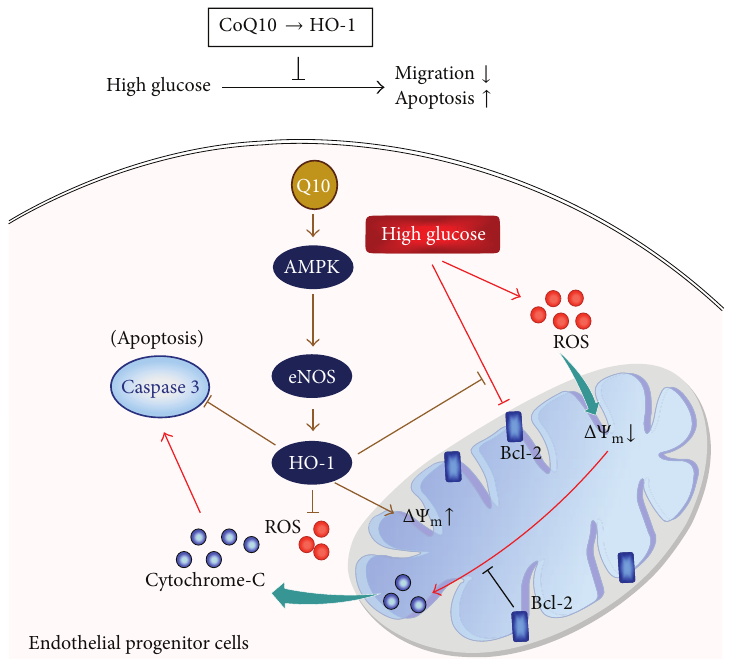
Figure 7: The schematic diagram summarizes possible mechanisms by which CoQ10 reduces hyperglycemia-induced endothelial progenitor cell damage. In high glucose condition, CoQ10 improved EPCs migration and apoptosis by ROS and caspase 3 downregulation and mitochondrial membrane potential ( ΔΨ m ) and Bcl-2 upregulation through HO-1